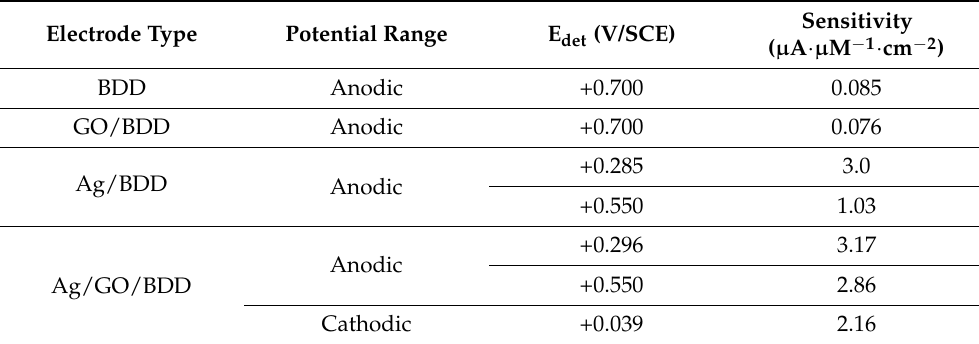
Table 2. Comparative detection potential values and the